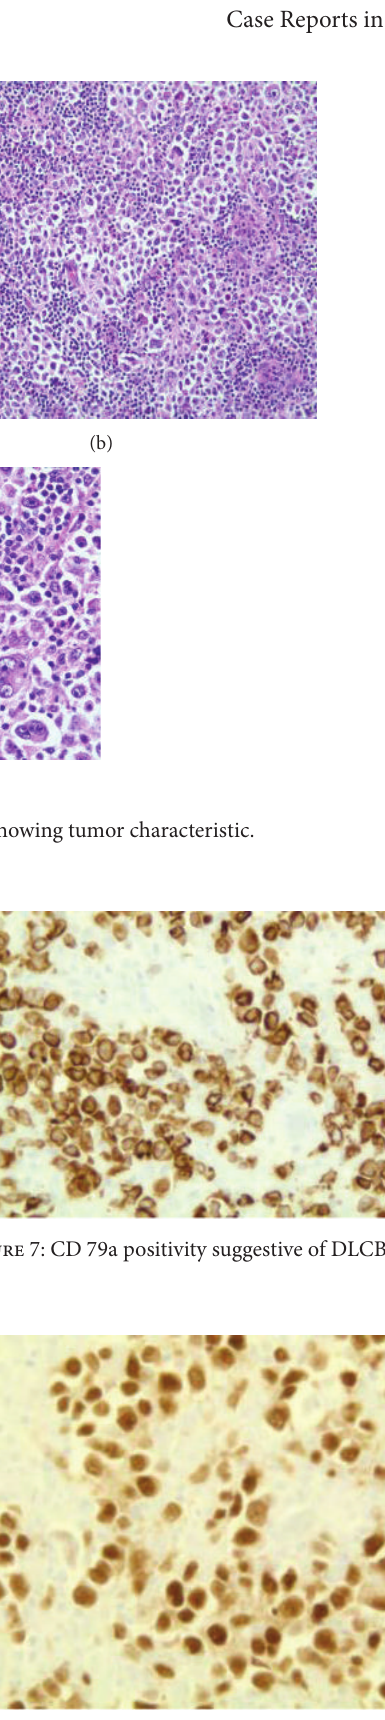
Figure 8: PAX 5 positivity suggestive of DLCBL